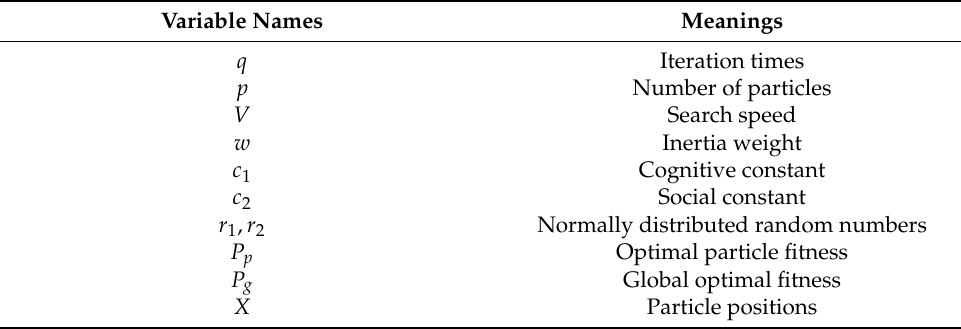
Table 2. Parameter settings in the iterative